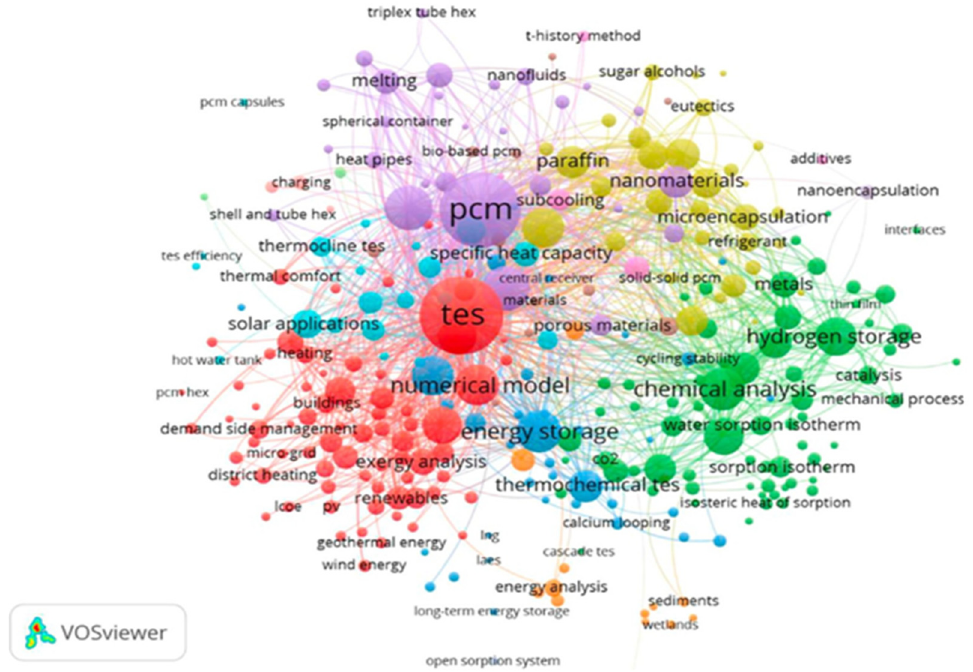
Figure 3. Keywords’ co-occurrence for the storage sector [26], reprinted/adapted with permission from Ref. [26], 2022, Elsevier.